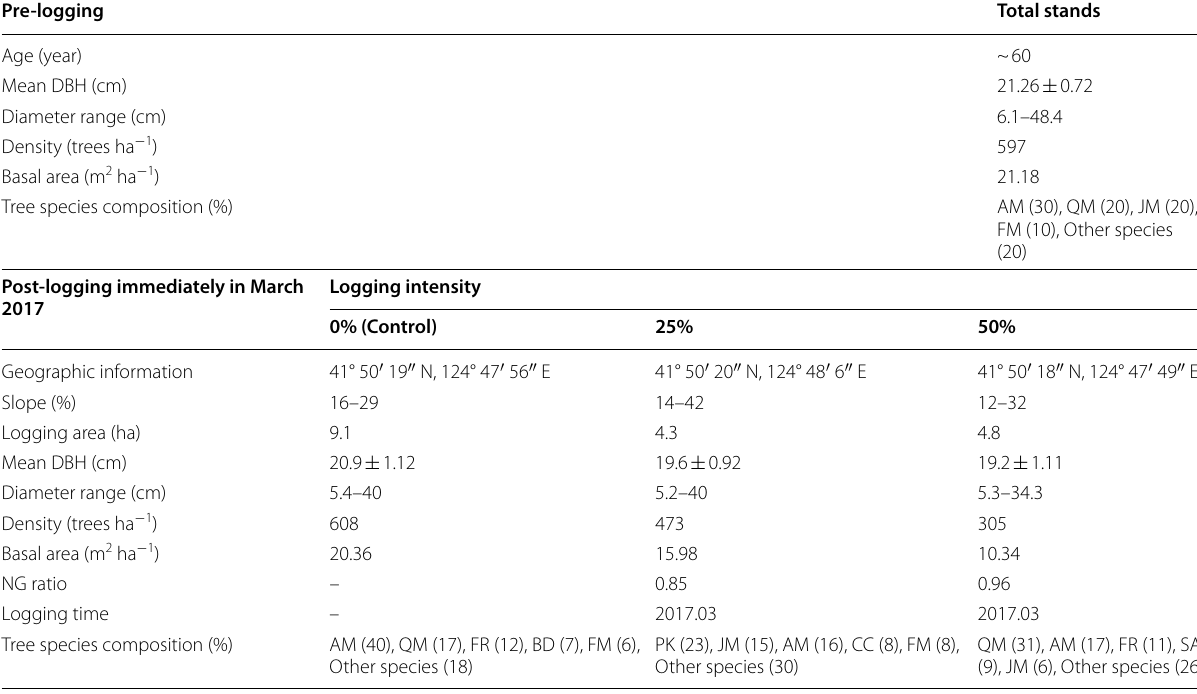
DBH: diameter of trees at breast height. The values of DBH are presented as means The tree species composition is determined by percent of density (trees ha − 1 ) AM Acer mono ; QM Quercus mongolica ; FR = = mandshurica ; CC Cornus controversa ; SA =